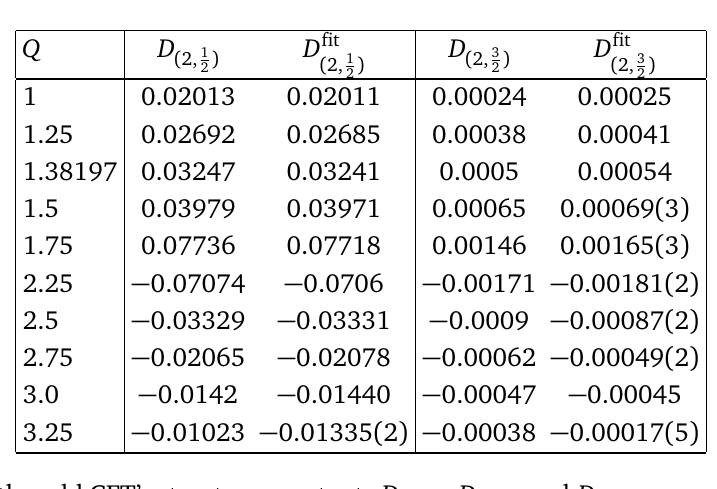
Table 3.6: Comparison of the numerically determined parameters of the fit (69) with structure constants of the odd